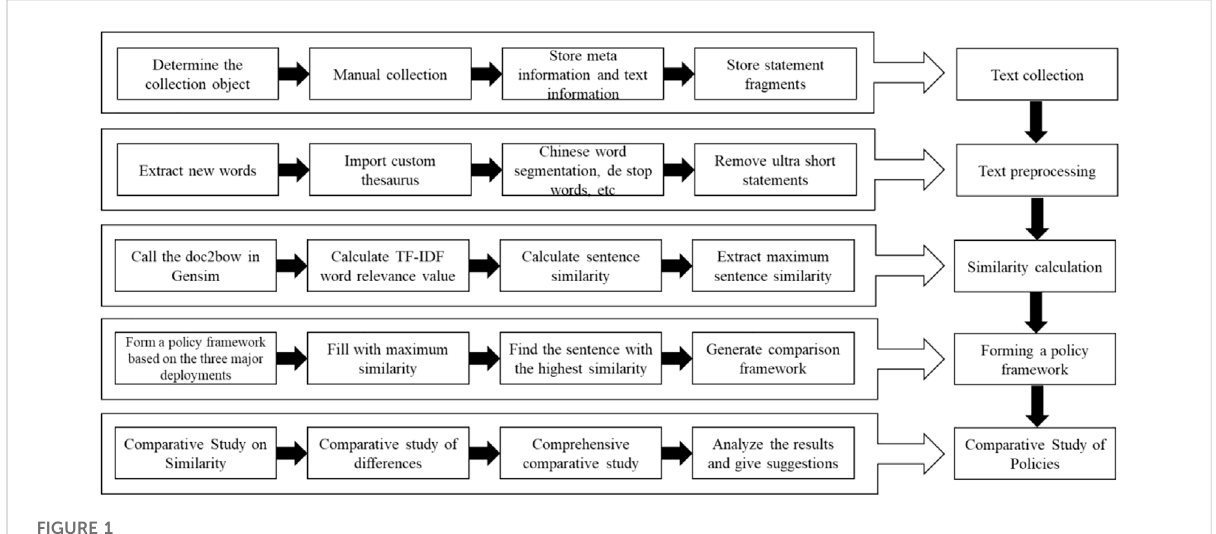
FIGURE 1 Research fl ow chart based on the text similarity